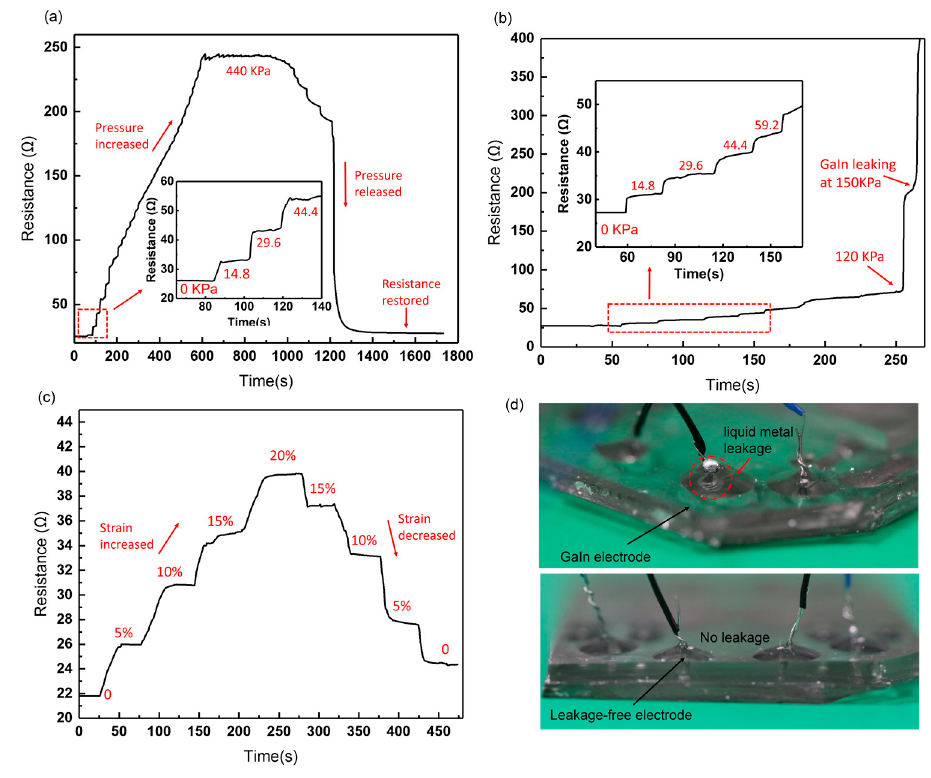
Figure 12. Real-time resistance response curves of ( a ) the leakage-free electrode under pressure from 0 to 0.44 MPa; ( b ) the GaIn-only electrode under pressure from 0 to 0.15 MPa; ( c ) the leakage-free electrode under strain from 0 to 20%; ( d ) liquid metal of the GaIn-only electrode leaks at 0.15 MPa .